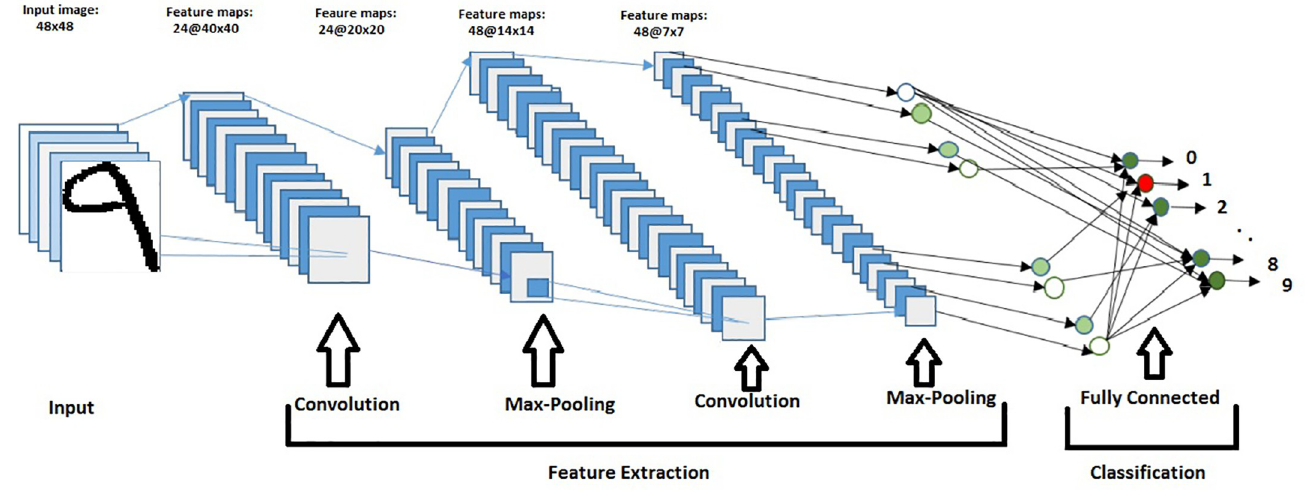
Fig 3. Proposed CNNs